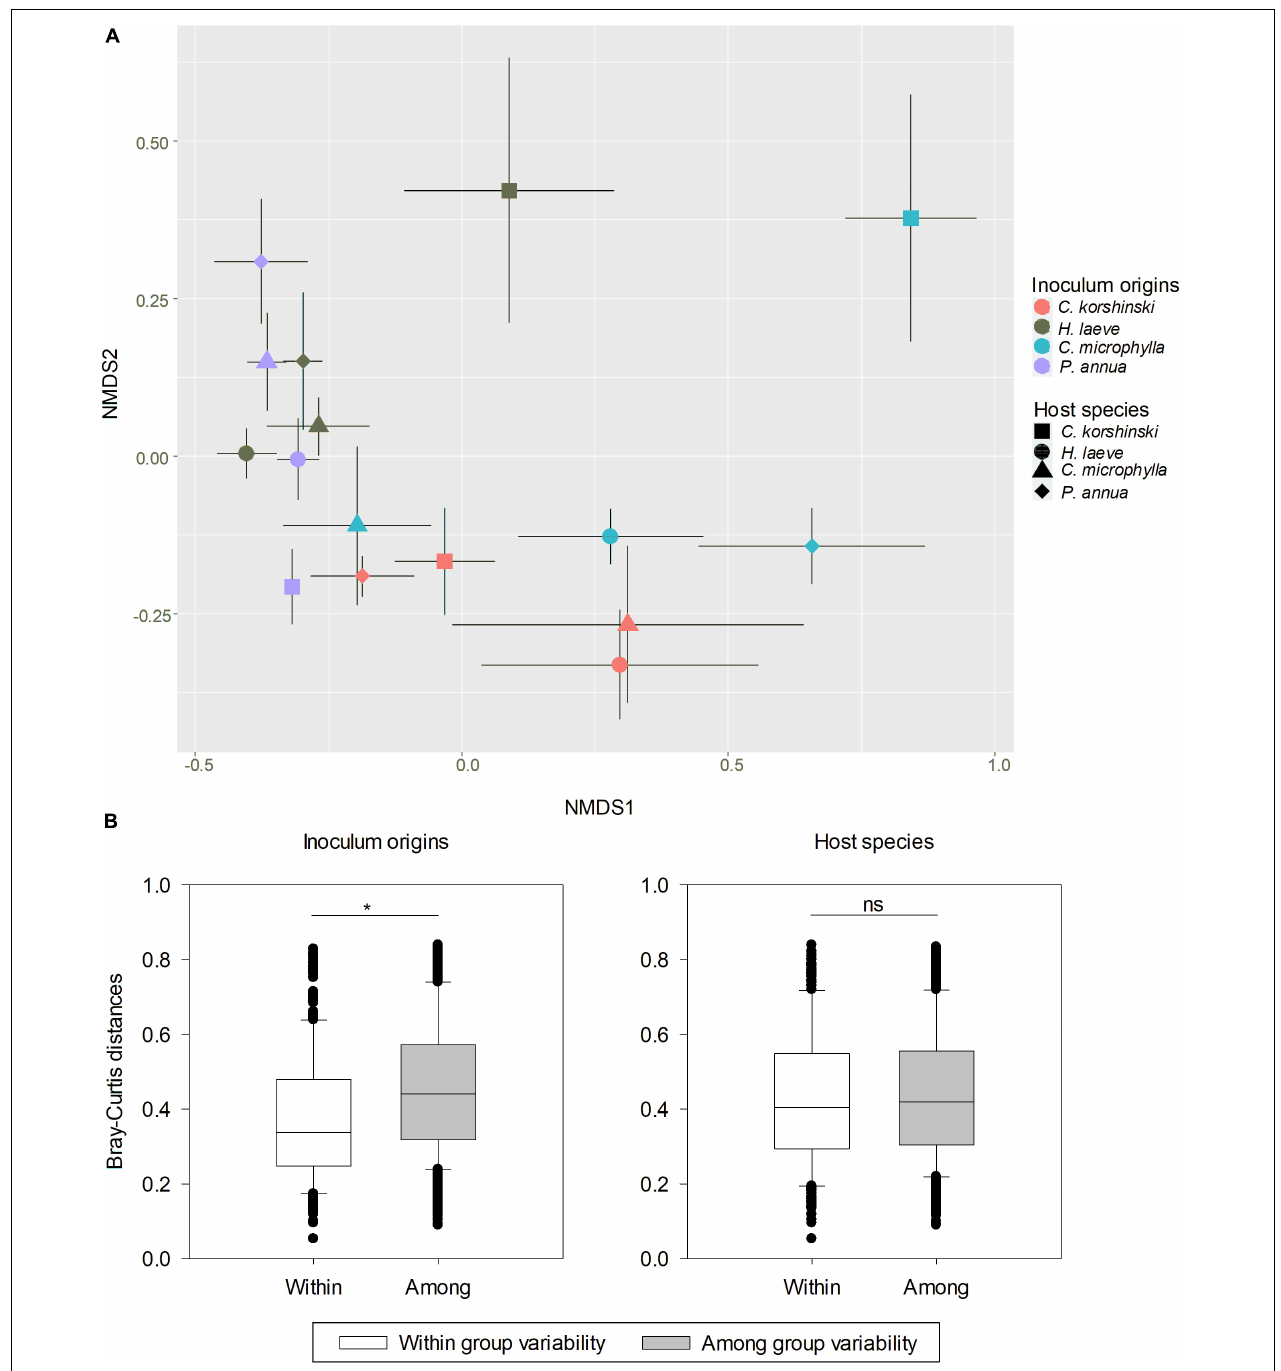
FIGURE 2 | Changes in soil AMF community structure under different host species and inoculum origin. (A) Non-metric multidimensional scaling (NMDS) illustrates the differences in AMF communities for host plant species and inoculum origin (stress = 0.135). (B) Pairwise comparisons of Bray–Curtis distances among all rhizosphere AMF communities, either those associated with the same host species or the same inoculum origin (category “Within”) or those associated with two different host species or inoculum origins (category “Among”). T -test results showed a significant effect of inoculum origins on the dissimilarity of the AMF